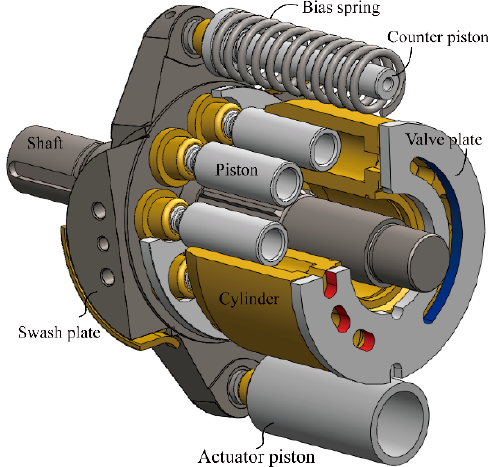
Figure 1. Schematic of the variable displacement pump.